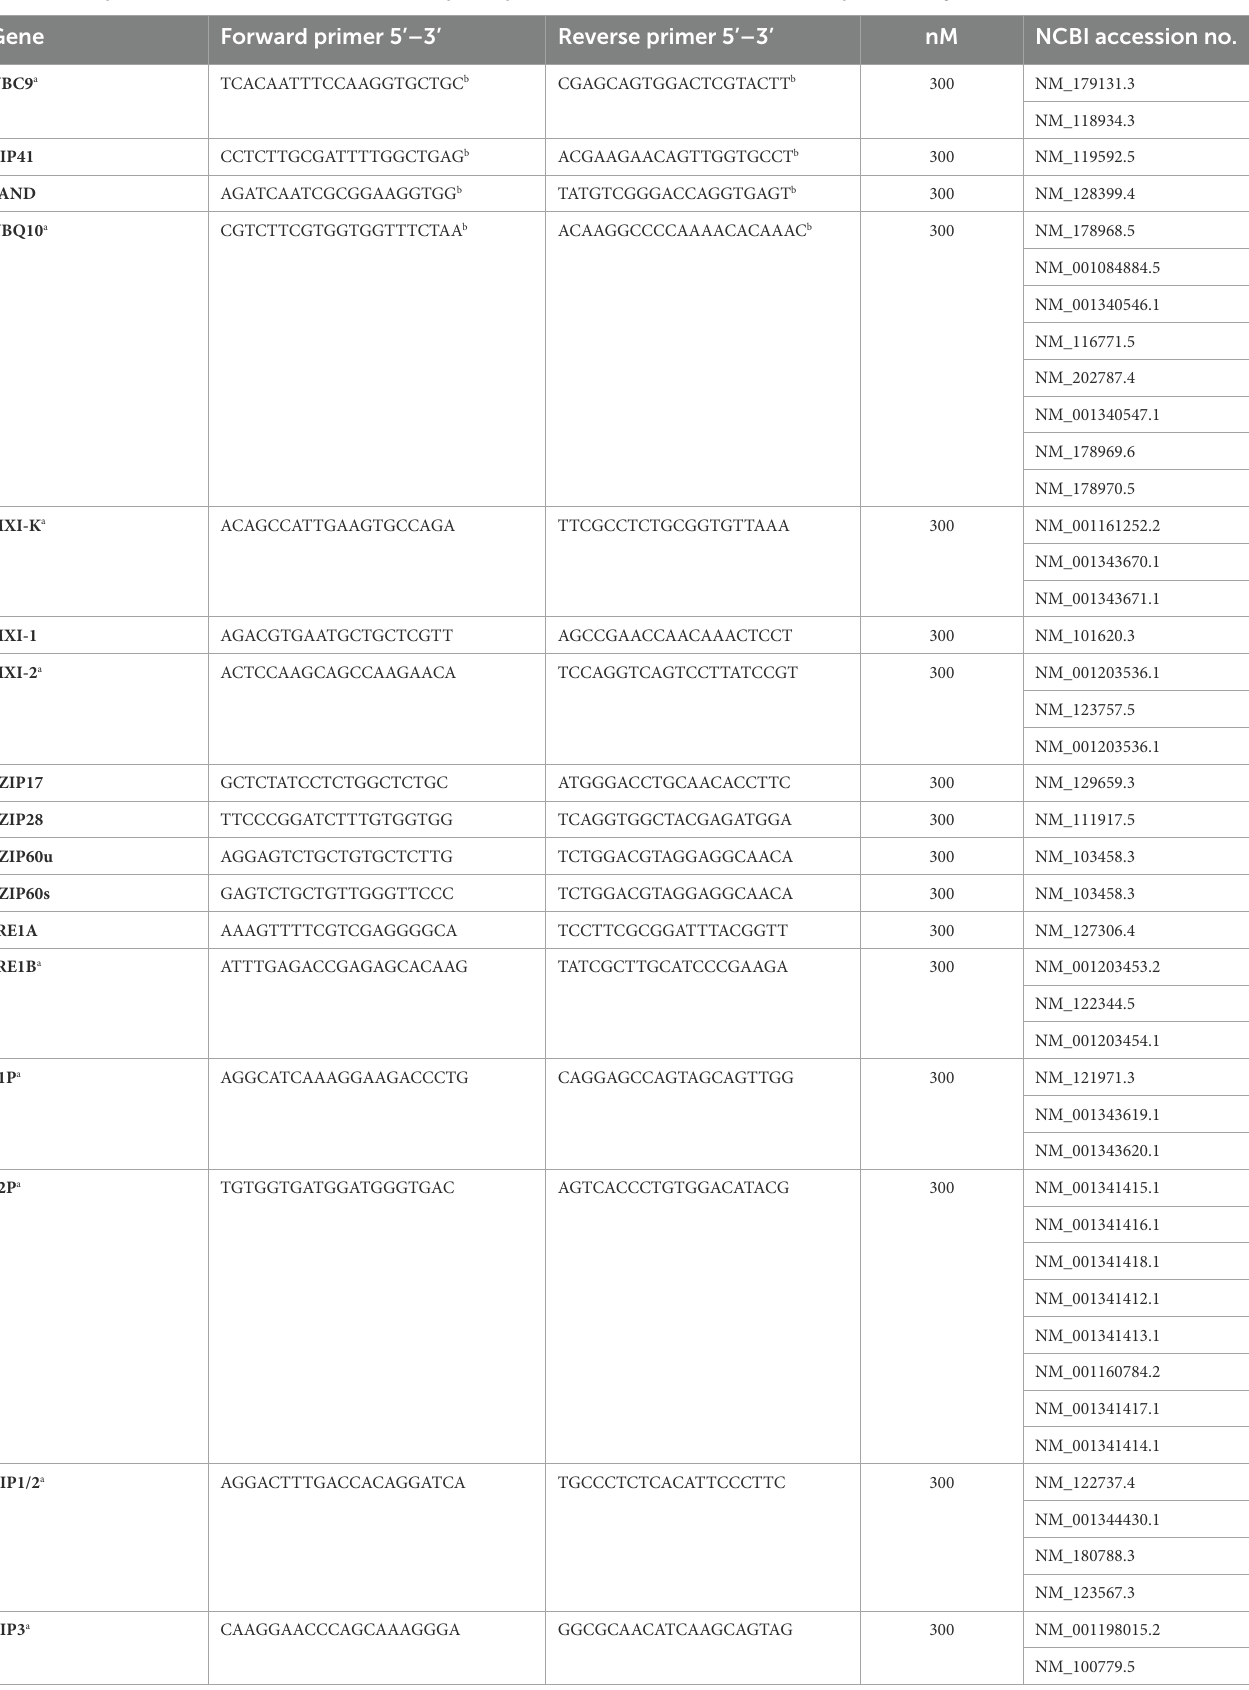
TABLE 2 List of primers and accession number of Arabidopsis sequences used in real-time RT-PCRs in the present study.